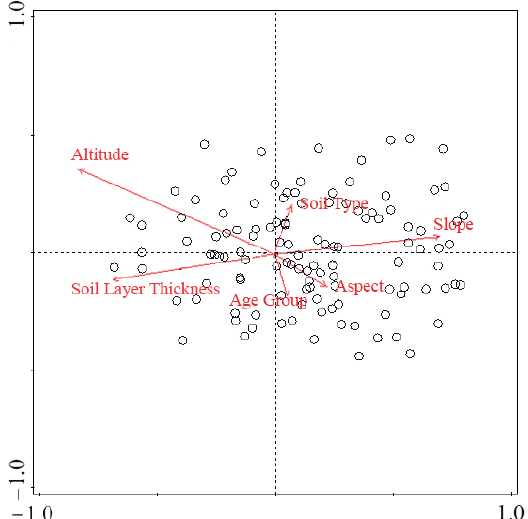
Figure 8. The CCA ranking chart for the ground survey sites and impact factors. The horizontal axis corresponds to the first ranking axis, the vertical axis corresponds to the second ranking axis, black circles are damage degree data of survey sites and red arrows represent environmental impact factors.